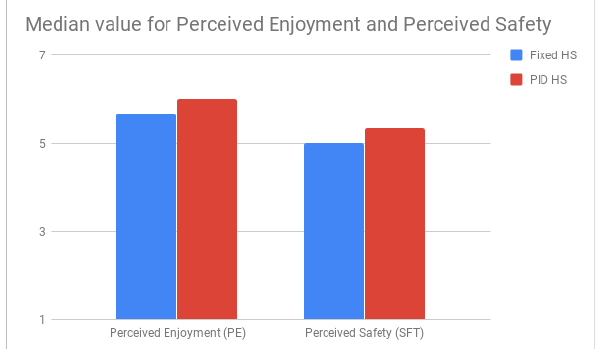
Figure 14: Median values for Perceived Safety and Perceived Enjoy-